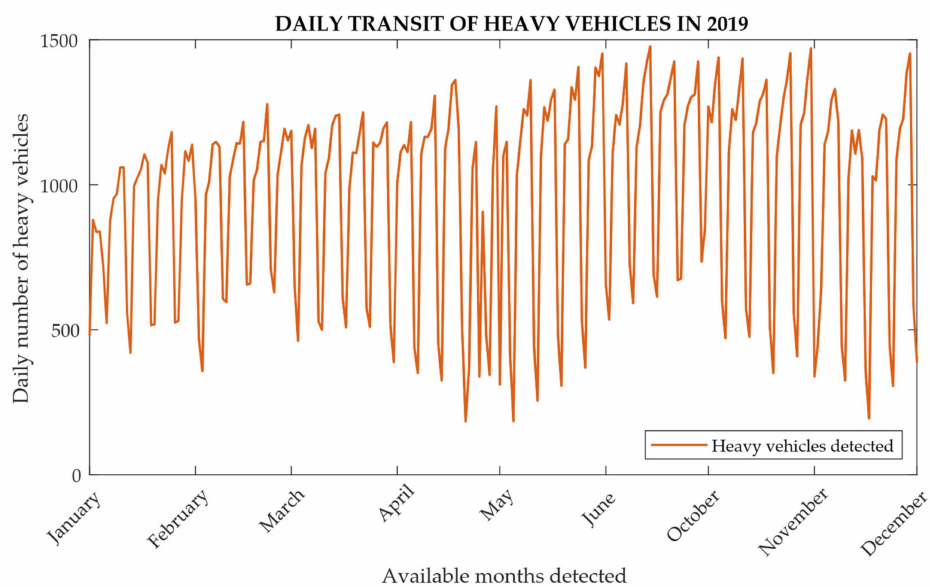
Figure 20. Data of the daily transit of heavy vehicles between October and June recorded in 2019 in the highway section of the case study viaduct.